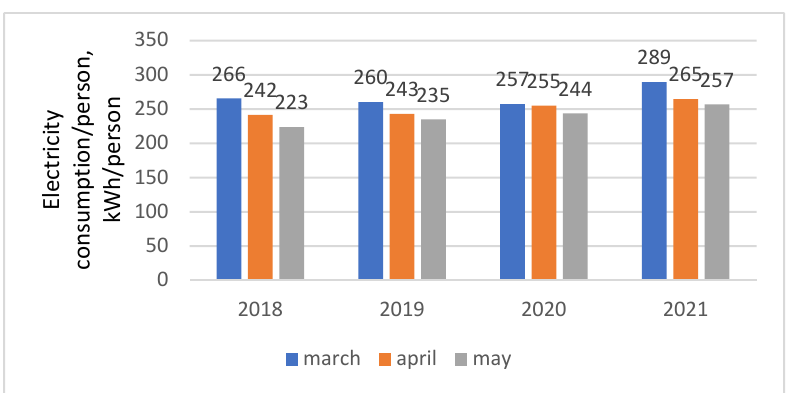
Table 5. Electricity consumption and the number of electricity consumers in Atyrau in March, April, and May for 2018– 2021 in kWh.